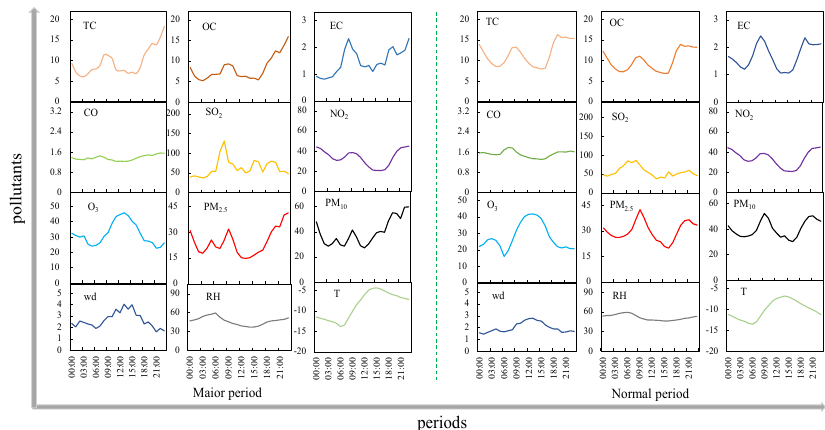
Figure 2. Hourly variations in the pollutant concentrations (i.e., total carbon (TC), organic carbon (OC), elemental carbon (EC), particulate matter (PM 2.5 and PM 10 ), SO 2 , NO 2 , CO, and O 3 ) and meteorological parameters (i.e., temperature, relative humidity, precipitation, wind direction, and wind speed) in Changchun during the Spring Festival (i.e., from Lunar 20 December to Lunar 20 January of the following year). The shaded areas represent five typical holiday periods: I (i.e., the Lunar Little New Year); II (i.e., the Chinese New Year’s Eve); III (i.e., Lunar 5 January); IV (i.e., the Spring Lantern Festival), and V (i.e., Chinese Lunar New Year legal holidays, from Lunar 30 December to Lunar 7 January of the following year).